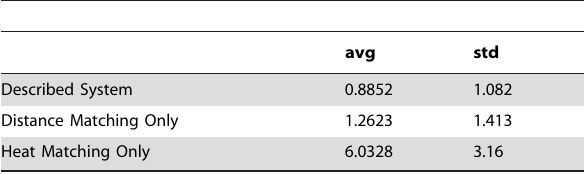
Table 1. Number of manual interventions every 30sec used to correct the identities exchange od the tracking algorithm on dataset A.